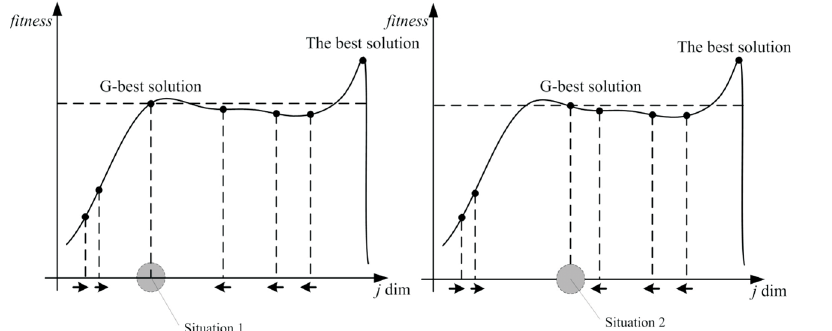
Fig 1. Situations in advanced steps in